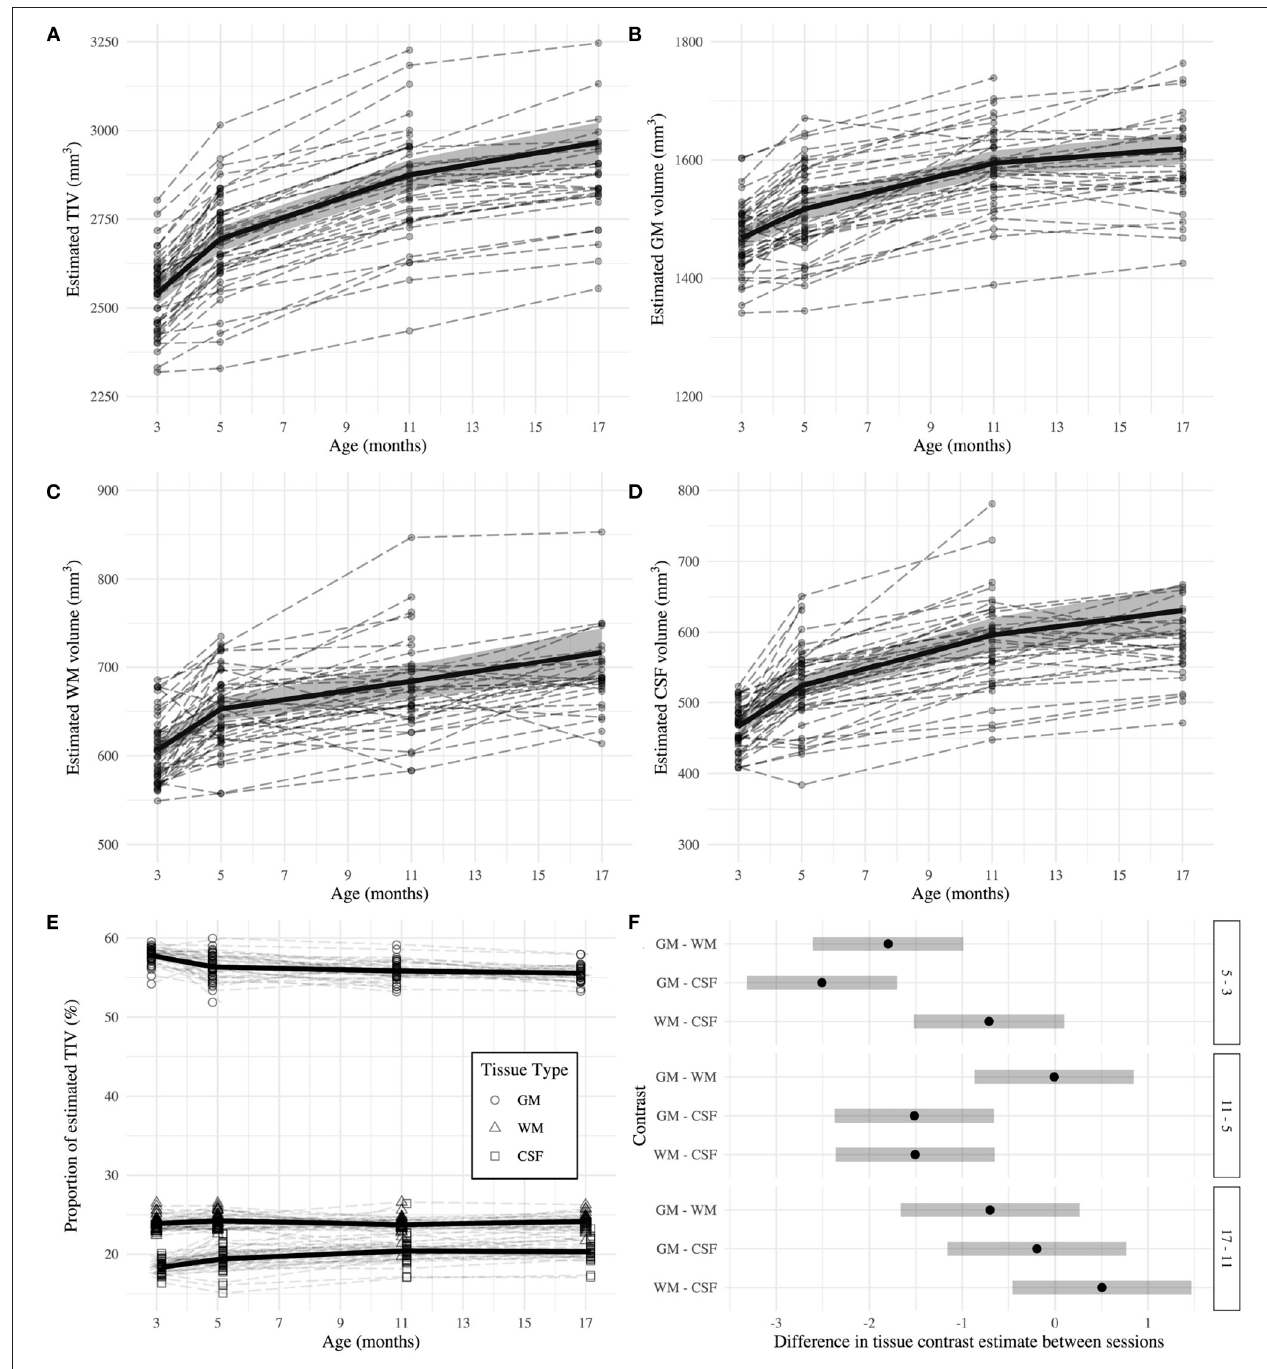
FIGURE 3 | Estimates of total intracranial (A) , gray matter (B) , white matter (C) , and CSF (D) volumes across adulthood in the rat. (E) Relative proportion of tissue volumes with respect to total intracranial volume. The dashed lines represent individual trajectories, while the solid line and background fill connects the mixed-effects model estimated marginal means ± 95% confidence interval of the estimate. (F) Second level contrast plots indicating the size and direction of the difference between contrasts of consecutive sessions for each tissue type. The dots denote the estimate difference and the bars denote the 95% confidence interval of the